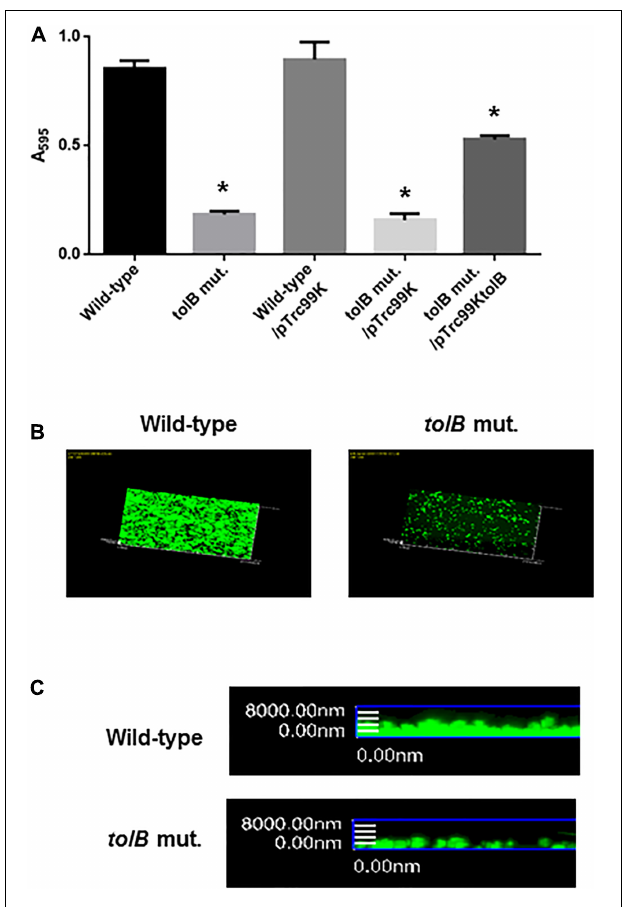
FIGURE 1 | Bacterial adhesion and aggregation on 96-well polystyrene plates in the wild-type parent and the tolB mutant, or the wild-type parent and the tolB mutant carrying pTrc99K (empty vector) or pTrc99KtolB ( tolB expression plasmid) (A) . Bacterial adhesion and aggregation were represented as A 595 values normalized to OD 600 of 1. Data plotted are the means of three biological replicates, error bars indicate the ranges, ∗ P < 0.01. Asterisks denote significance for values relative to the wild-type control. Attachment of the wild-type parent and the tolB mutant on cover glasses. Bacteria stained with SYTO-9 were imaged as a green fluorescent color on the microscopy using 60 × objective. Overlooking (B) and cross sectional (C) images were acquired for each sample. The experiment was repeated twice and similar results were